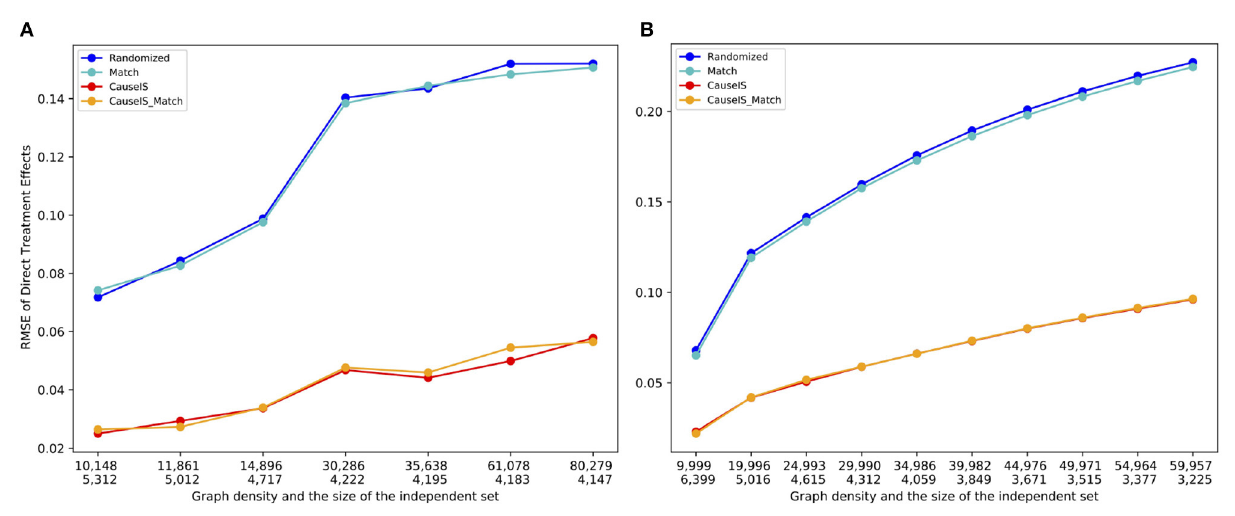
FIGURE6 RMSE of direct treatment effects in synthetic data with 10,000 nodes and different densities. Numbers in the first row of the x-axis show the number of edges in graphs, and the second row represents the size of MIS. (A) Forest Fire model. (B) Barab’asi-Albert model.